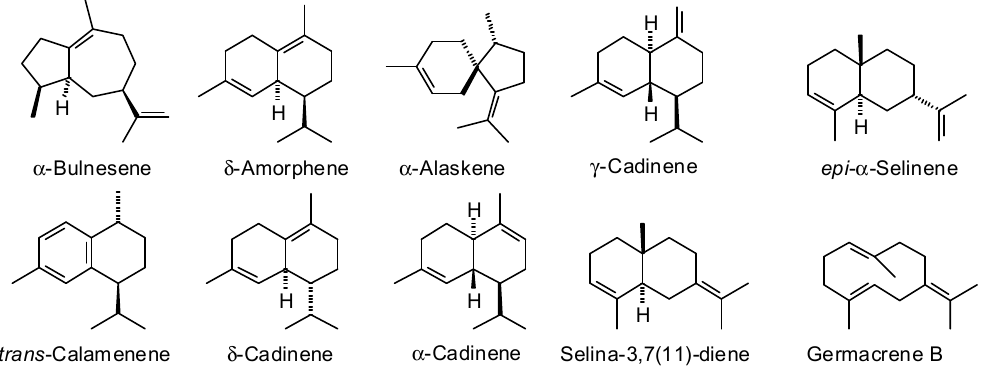
Figure A2. Major sesquiterpene hydrocarbons found in Neotropical Piper species.